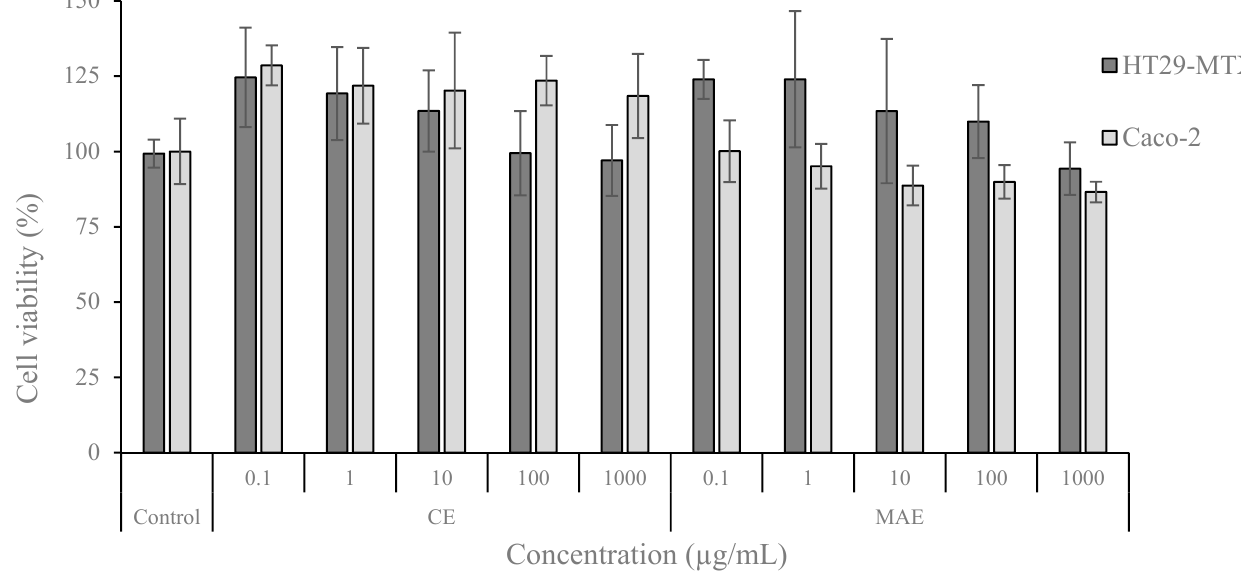
Figure 2. Effects of S. ramosissima extracts prepared by CE and MAE on the viability of HT29-MTX and Caco-2 at a range of concentrations 0.1–1000 µg/mL, as measured by the MTT assay ( n = 3).